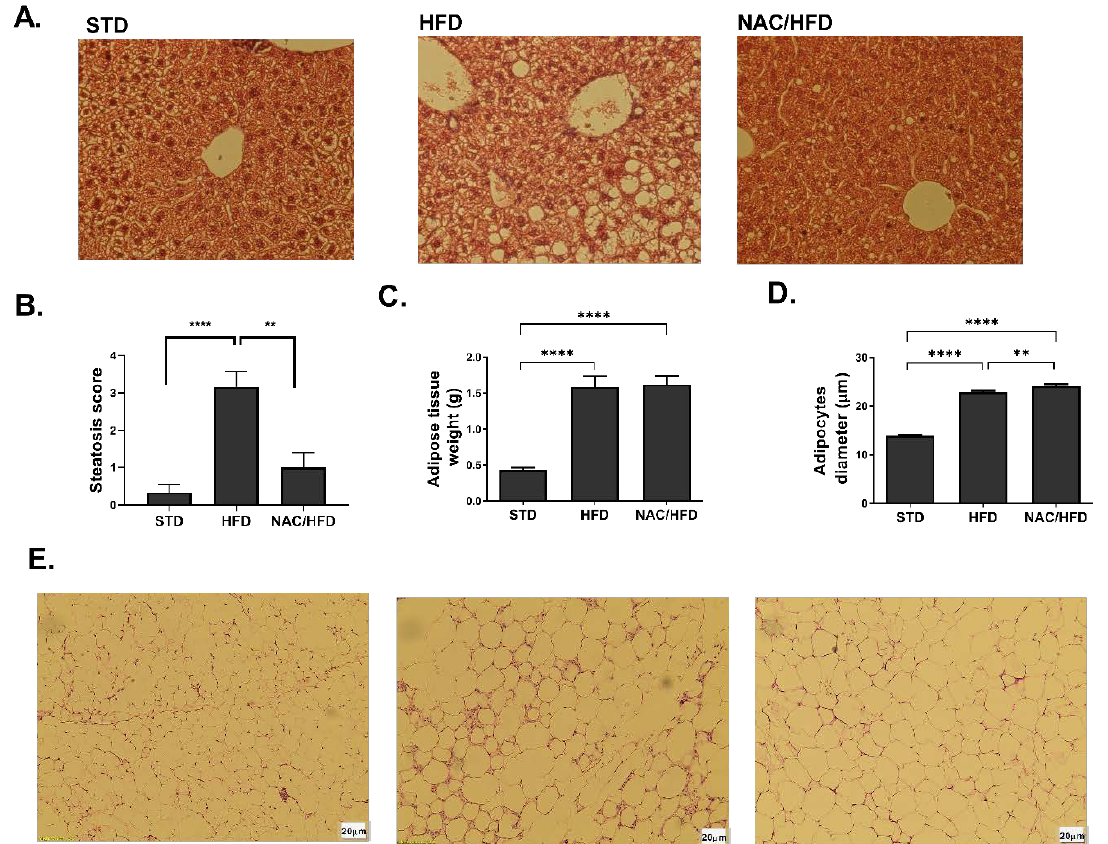
Figure 4. NAC reduced severity of hepatic steatosis and adipose tissue inflammation in HFD-fed offspring male mice. NAC was given to females during pregnancy and lactation. HFD was given to offspring from the age of 6 weeks. Mice were killed at age 16 weeks and H&E staining of liver ( A ) and adipose tissue ( E ) was performed. Severity of steatosis was graded using steatosis score, as described in Methods ( B ). Visceral adipose tissue weight was measured ( C ) and adipocyte diameter was measured ( D ). C/STD: STD-fed offspring of control mice, C/HFD: HFD-fed offspring of control mice, NAC/HFD: HFD-fed offspring of NAC-treated mice. The results are presented as mean±SE ( n ≥ 4), ** p < 0.005, **** p < 0.005 in one-way Anova followed by Tukey's post-test.